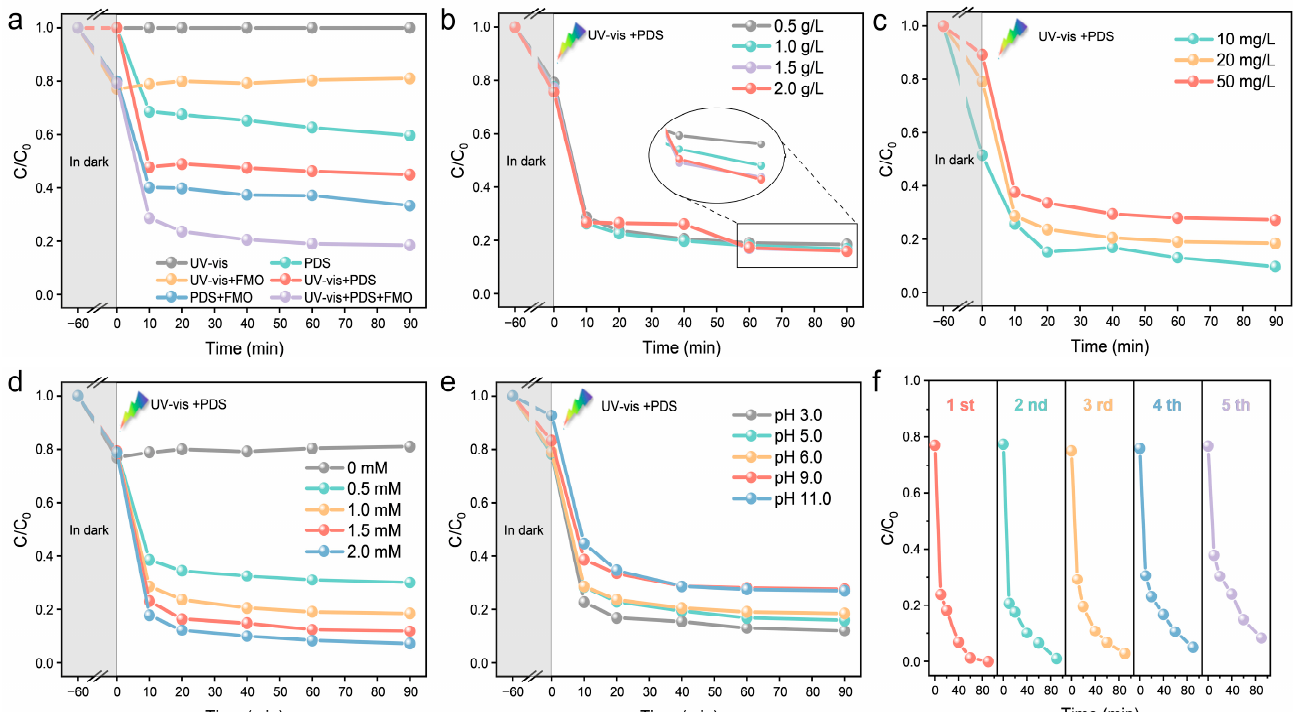
Figure 4. ( a ) Degradation rates of MO under different systems; effects of ( b ) catalyst dosage, ( c ) initial concentration of OFL, ( d ) PMS dosage and ( e ) initial pH; ( f ) reusability of FMO-6.